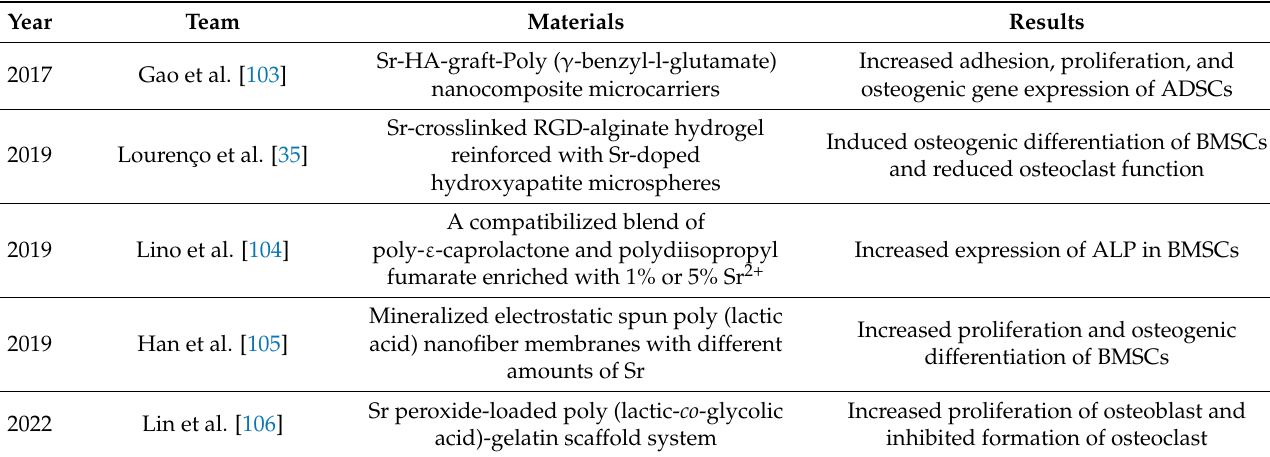
Table 5. The application of Sr compound with synthetic